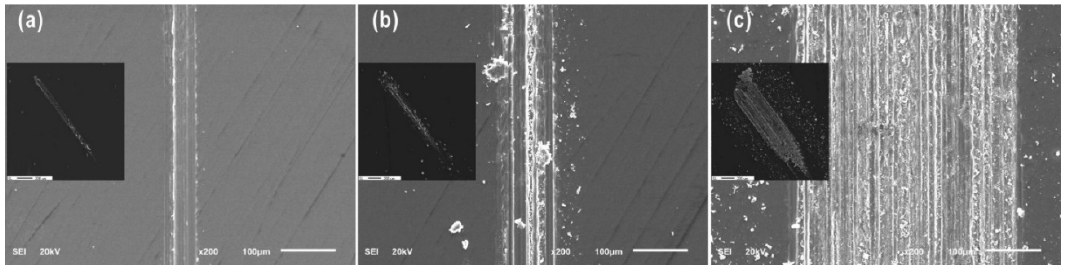
Figure 5. SEM images of wear debris formed at a load of 0.1 N after ( a ) 10 cycles, ( b ) 100 cycles, and ( c ) 1000 cycles.